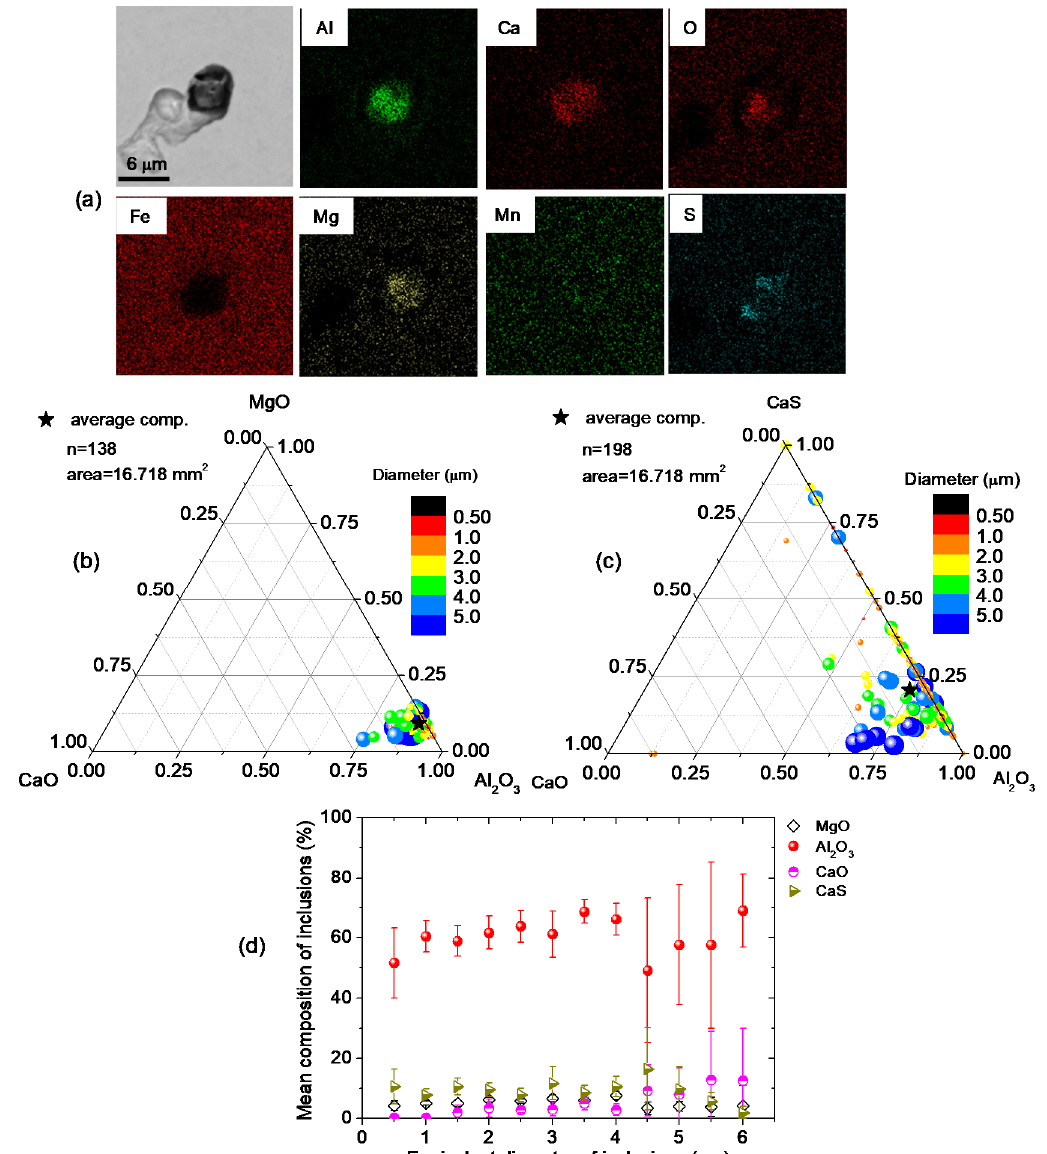
Figure 4. ( a ) Element mapping of a typical inclusions formed at the cooling rate of 0.035 K/s. Summary of the ( b – c ) composition and size distributions of inclusions and ( d ) variations in composition of inclusions against its diameter formed at the cooling rate of 0.035 K/s.